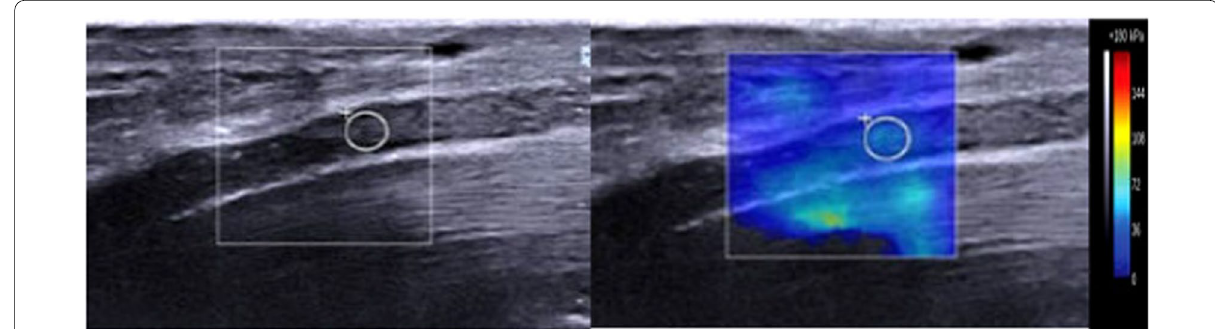
Fig. 6 A 49 years old male patient with clinical evidence of DPN. (Left) high resolution ultrasound showed thickened tibial nerve with increased CSA (17.1 mm 2 ). (Right) shear-wave elastography of the tibial nerve displayed increased mean tibial nerve stiffness value